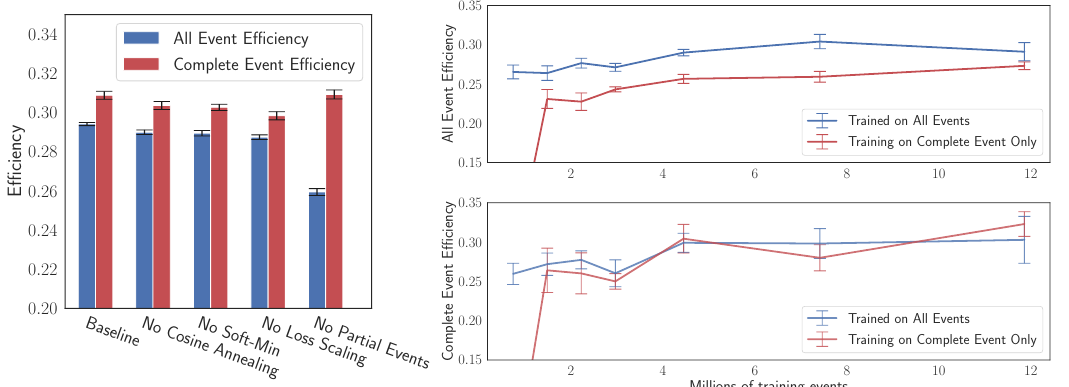
Figure 4: Ablation study efficiencies for both all and complete t ¯ tH events. Complete Events contain all resonance particles fully truth-matched to detected partons. All Events include complete events as well as partial events. Error bars indicate 95% confidence intervals over 8 training set